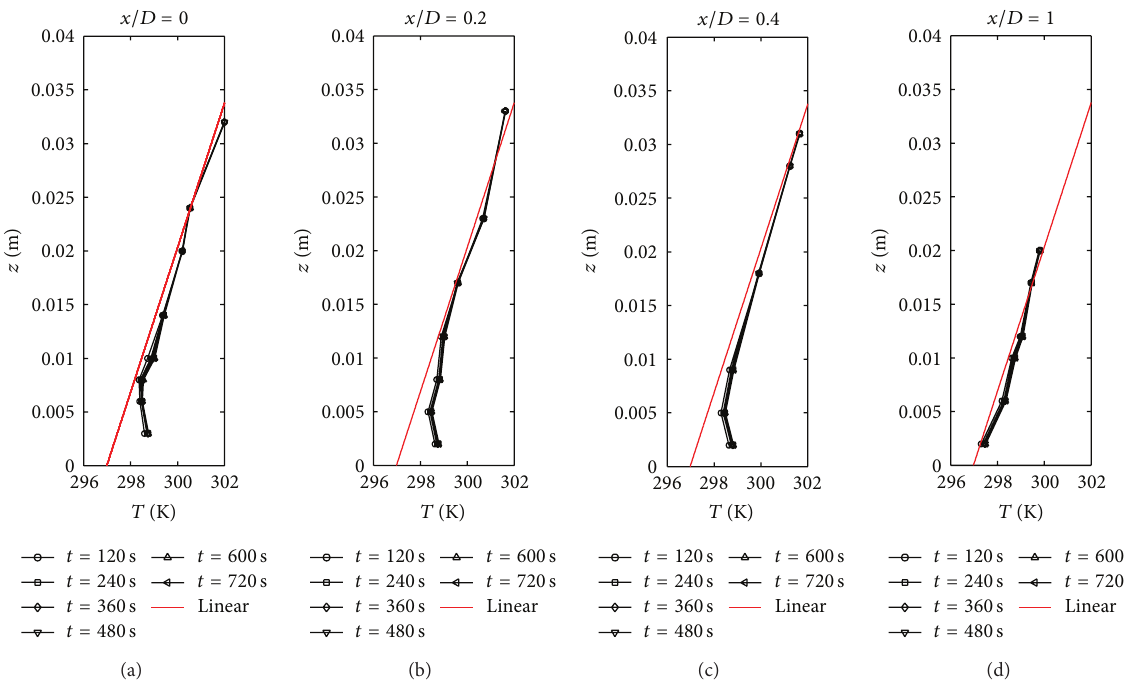
Figure 30: Mean temperature profiles as a function of the distance from the UHI center for the nocturnal UHI case.